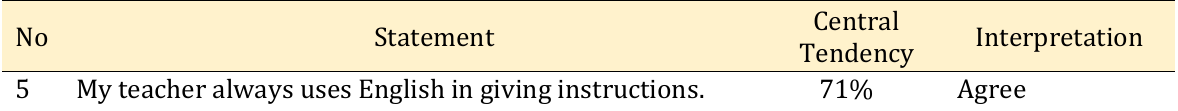
Table 5. Statement 5 questionnaire and interview